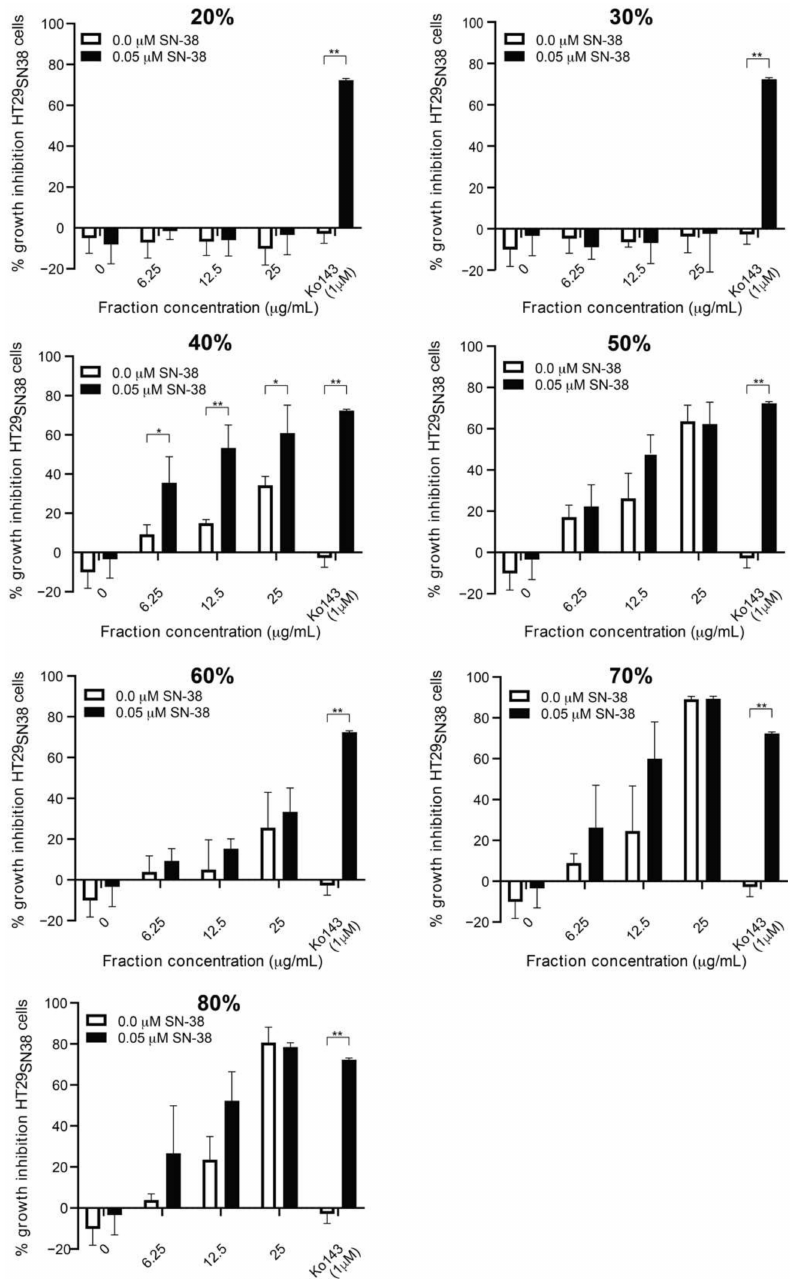
Figure 3. Growth inhibition (relative to untreated controls) of HT29 SN-38 resistant cells treated with SPE fractions eluted with 20%, 30%, 40%, 50%, 60%, 70%, and 80% acetonitrile:water, either alone or in combination with 0.05 µ M SN-38. Ko143 (at 1 µ M) was used as a positive control. Error bars indicate SD determined on the basis of n = 4. * p ≤ 0.05, ** p ≤